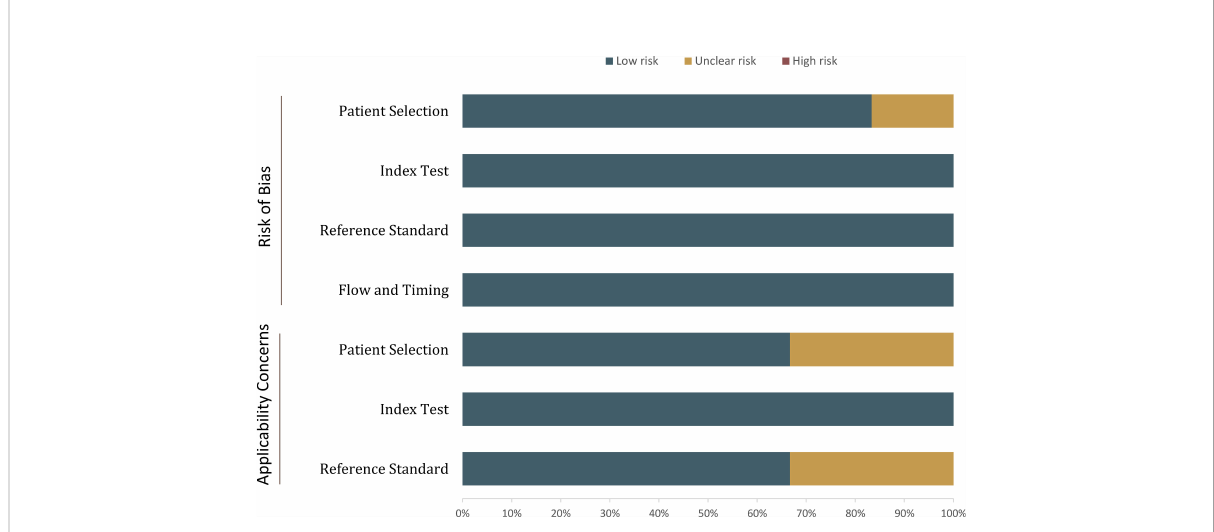
FIGURE 2 Grouped bar charts show the risk of bias and concerns for applicability of included studies.